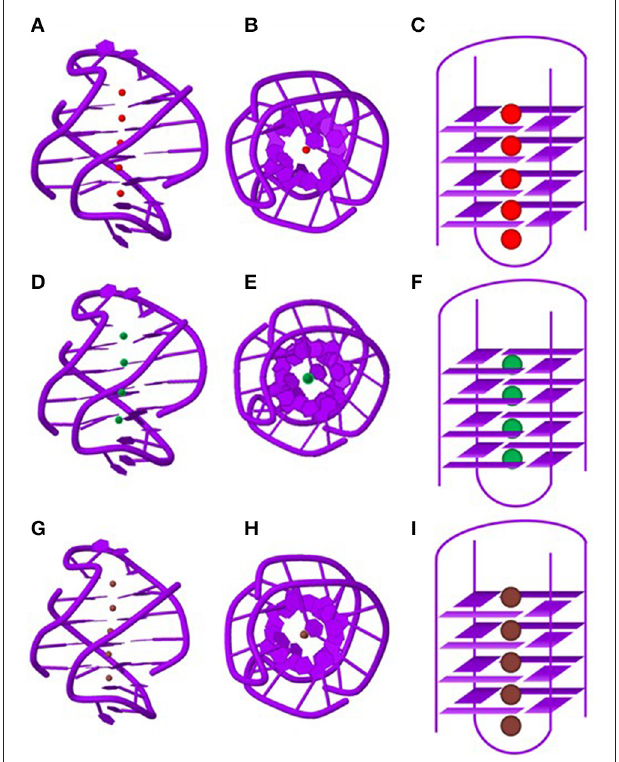
FIGURE 4 | Structure of the Oxytricha nova telomeric DNA d(GGGGTTTTGGGG) in the presence of different monovalent cations. The side views of the crystal structure in the presence of K + (A) , Na + (D) and Tl + (G) ions. A view shown down the central ion channel of the quadruplex in the presence of K + (B) , Na + (E) and Tl + (H) . Schematic representations of the bi-molecular quadruplex showing positions of the monovalent cations in the central ion channel. K + ions (C) and Tl + (I) ions are sandwiched between G-quartets whereas Na + (F) ions are located in plane with G-quartets. PDB entries (K + : IJPQ, Tl + : 2HBN and Na + :